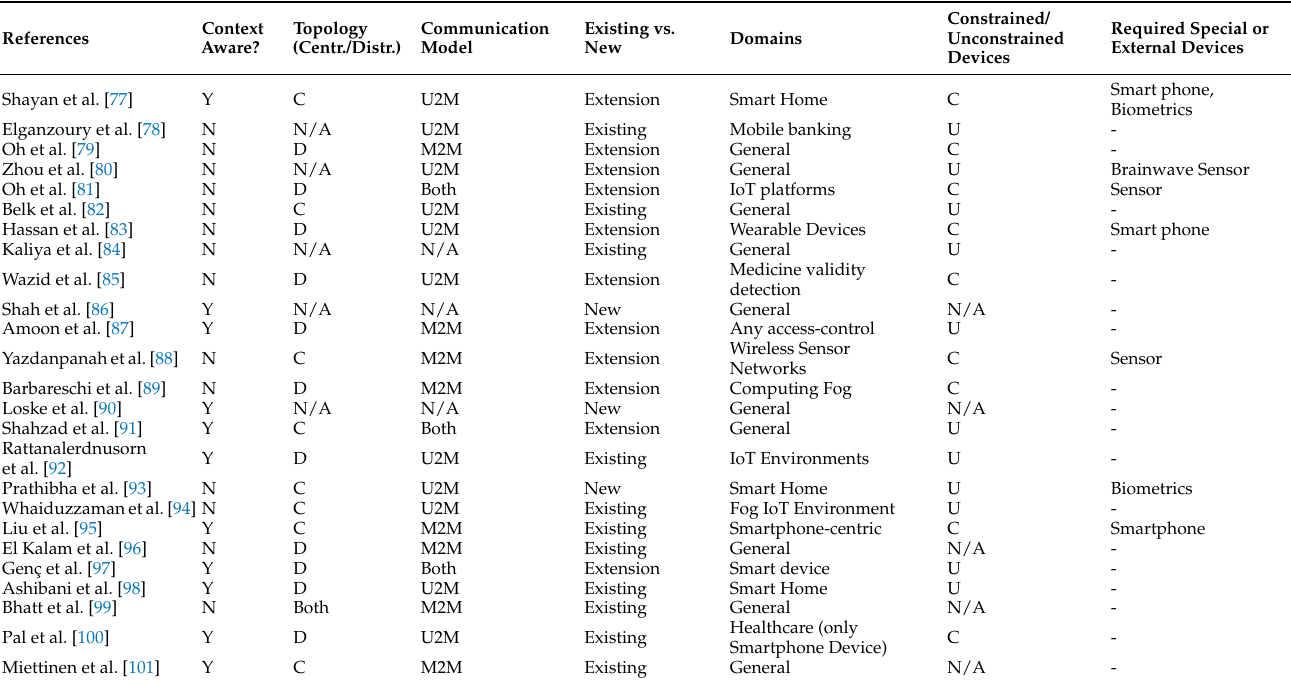
Table 5. Selected paper categorization part